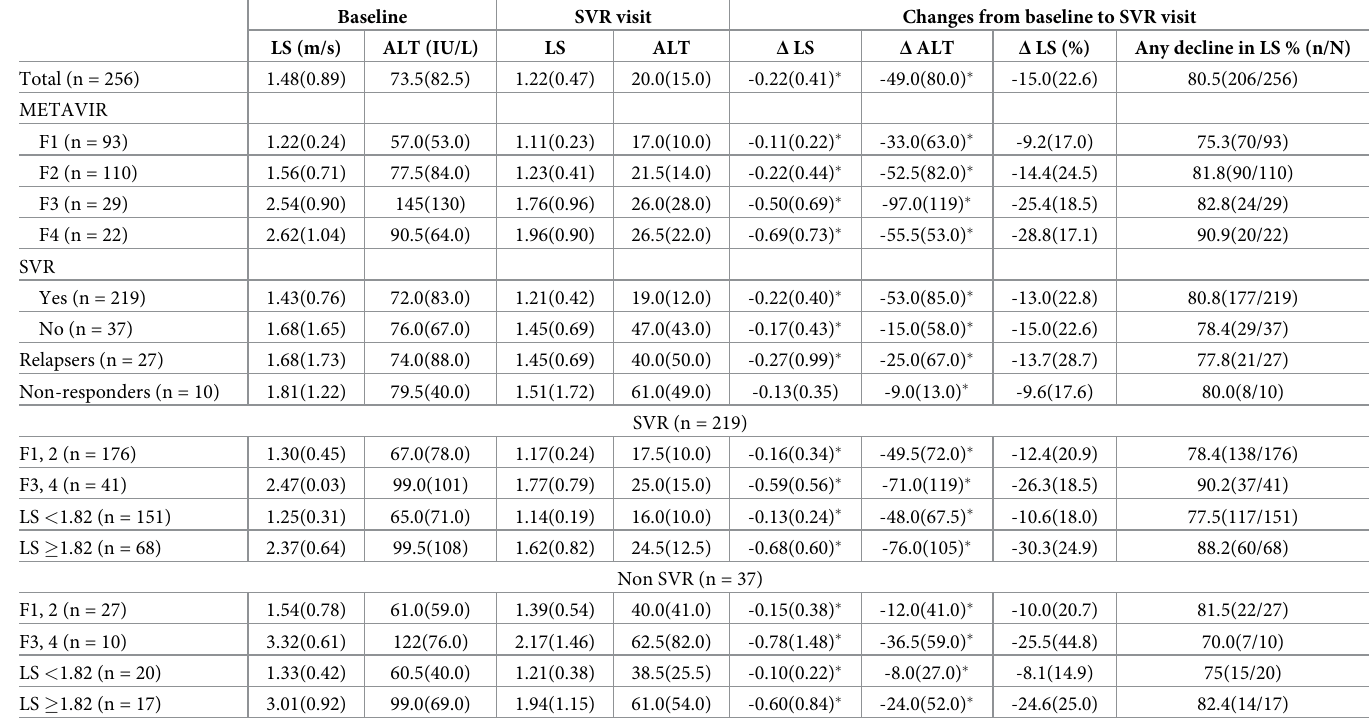
The results of ALT levels, the FIB-4 index, and APRI were consistent with those of the LSMs. The paired values of ALT, LS, the FIB-4 index, and APRI differed significantly from baseline to SVR visit (Fig 1; Tables 2 and 3). Linear and logistic regressions for measurements According to univariate and multiple linear regression analyses, BMI ( P = 0.0062) and baseline LS ( P < 0.0001) were identified as independent factors that explained LS decline (Table 4). For LS declines of > 4%, > 10%, and > 20% from the baseline, baseline LS remained indepen- dently significant (S1 – S6 Tables). In the subgroup including only patients with baseline advanced fibrosis (METAVIR F3) or cirrhosis (F4), baseline LS remained independently sig- nificant (S7 and S8 Tables). were identified as independent factors that explained the decline in the FIB-4 index (Table 4). Table 2. Stratified changes in liver stiffness and serum alanine aminotransferase levels from baseline to sustained virologic response visit. Baseline SVR visit Changes from baseline to SVR